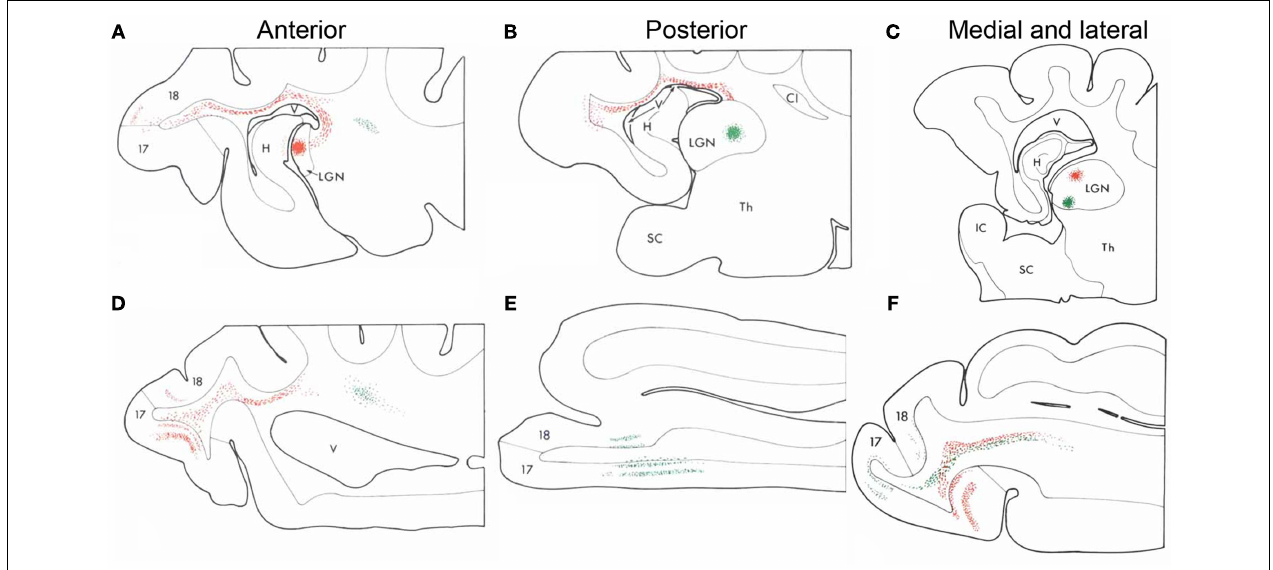
(D,E) , whereas the medio-lateral pairs of thalamic injections revealed fibers that crossed each other close to the primary visual cortex (F) .These experiments demonstrated that lateral geniculate nucleus (LGN) afferents perform transformation in the medio-lateral, but not the antero-posterior fashion in the catV1 close to the cortex in the white matter (Nelson and LeVay, 1985). Adapted from Nelson and LeVay (1985). H, hippocampus; IC, internal capsule;Th, thalamus;V,